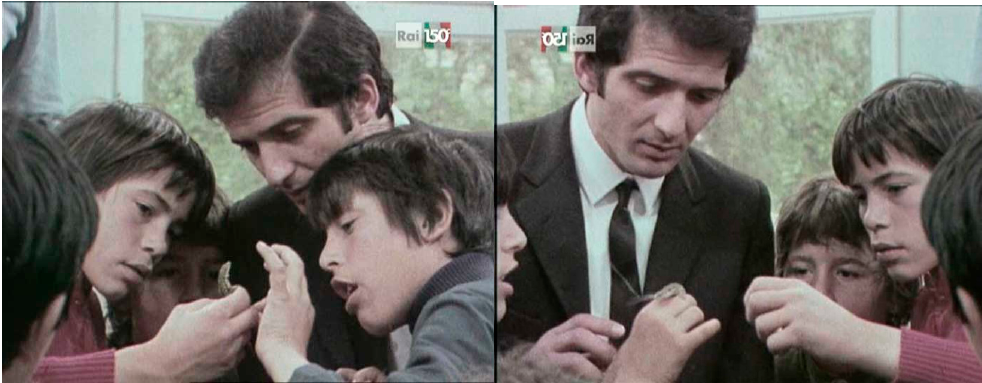
Figure 4. Photograms from the film Diario di un maestro , script and direction by Vittorio De Seta, subject by Albino Bernardini, Italy-Germany